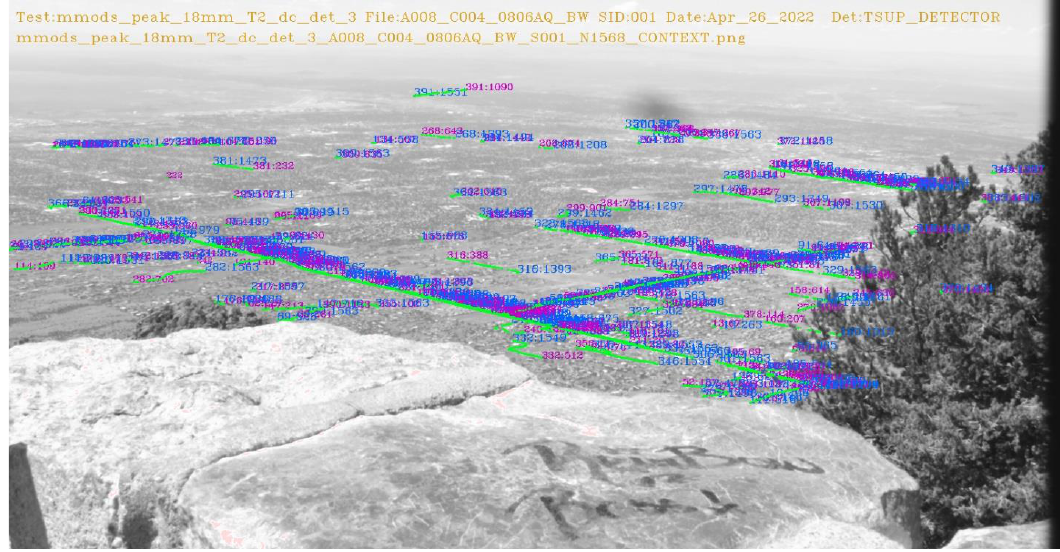
Figure 12. MMODS Detection on Sandia Mountain Peak.